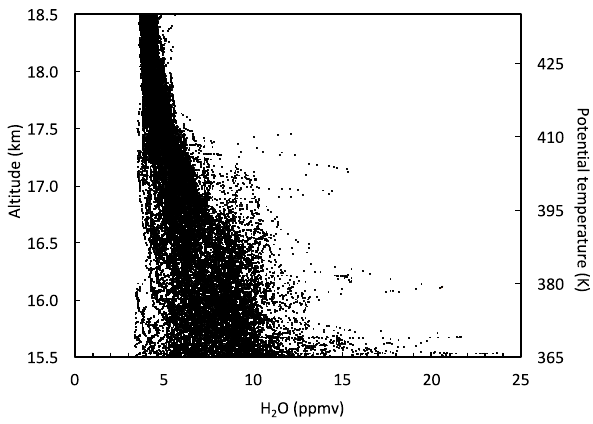
Figure 1. The JLH Mark2 stratospheric water vapor profiles from 23 aircraft flights during SEAC 4 RS. This altitude range includes the overworld stratosphere (potential temperature greater than 380K) and lowermost stratosphere (tropopause to 380K). The majority of the observations have mixing ratios lower than 10ppmv in the low- ermost stratosphere and lower than 6ppmv in the overworld strato- sphere. Enhanced water measurements are the extreme outliers with high water mixing ratios and a threshold value of the mean plus 2 standard